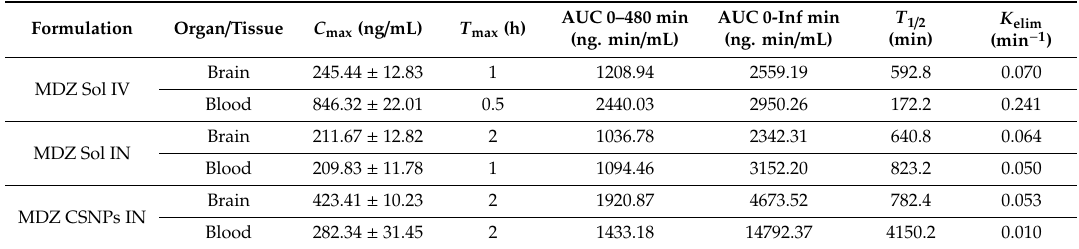
Table 3. Pharmacokinetic parameters of MDZ formulation after intranasal (IN) and intravenous (IV) administration in